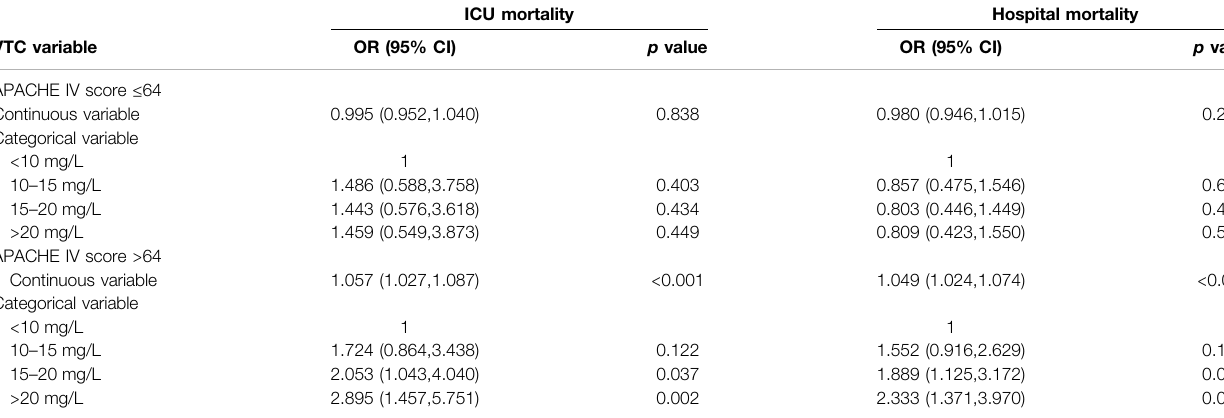
TABLE 3 | Multivariable analysis for the association of mean VTC with mortality in Apache IV score subgroups.